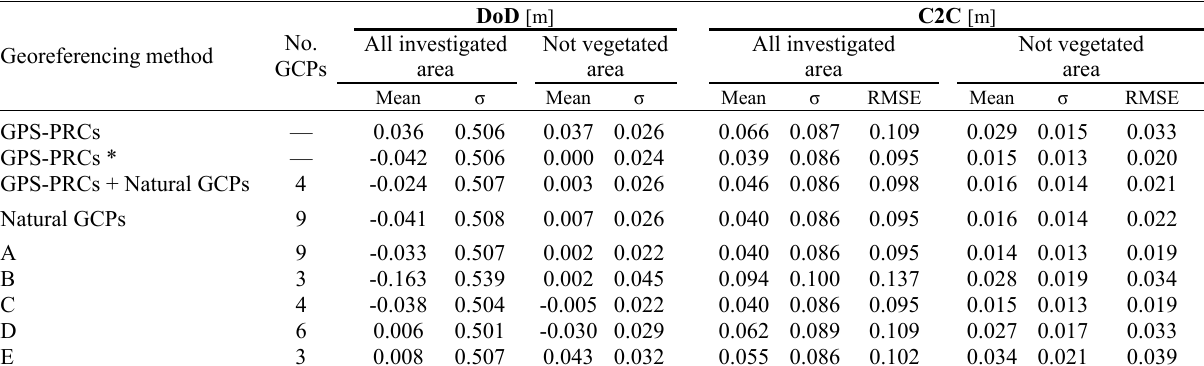
Table 4. Accuracy assessment based on the elevation difference (DoD) and the absolute distance (C2C) between the